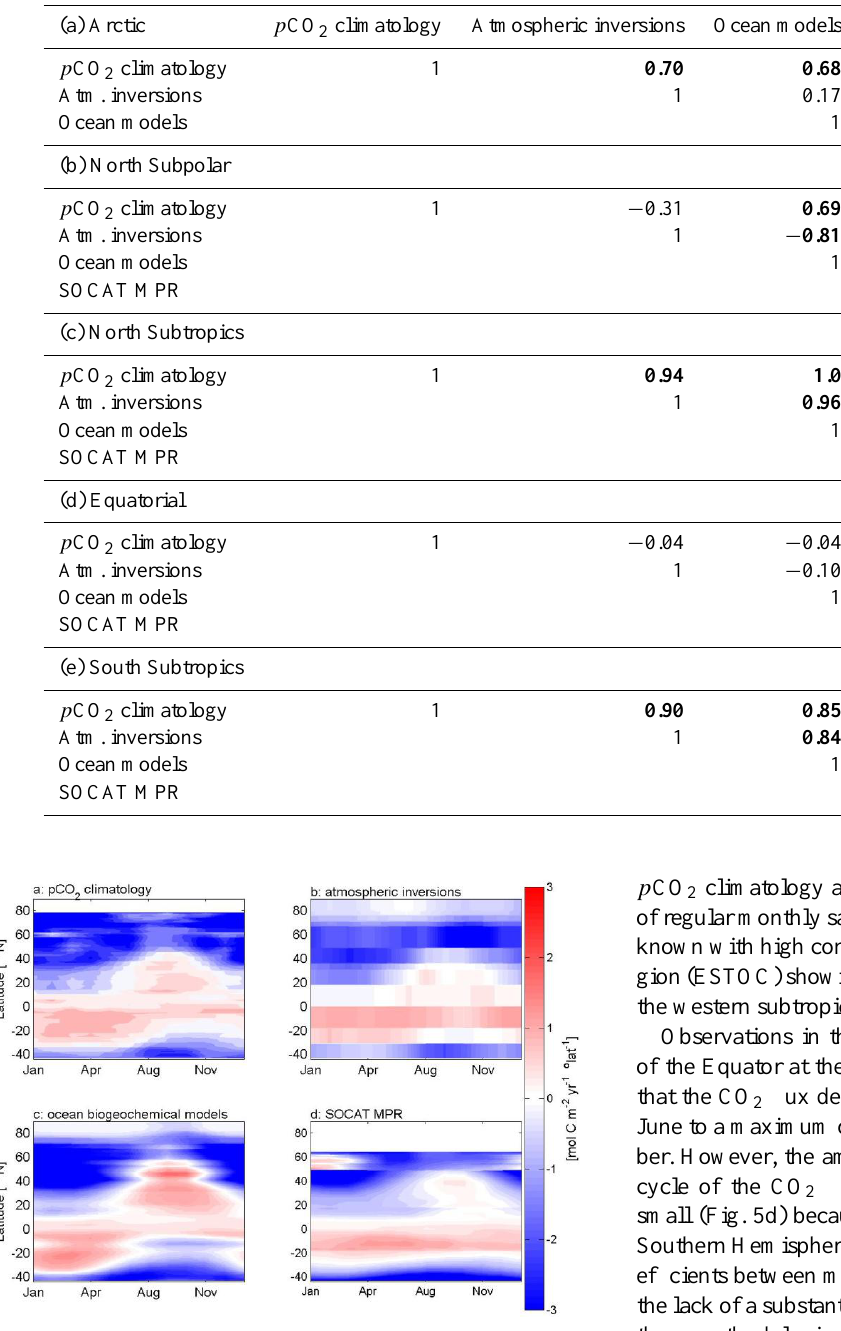
Fig. 4. Zonally averaged long-term mean seasonal cycle of Atlantic sea–air CO 2 flux density [molCm − 2 yr − 1 per degree of latitude], based on the Tier 1 methodologies: (a) p CO 2 climatology, (b) me- dian of atmospheric inversions, and (c) median of ocean biogeo- chemical models; additionally we show (d) the observations based SOCAT MPR. The p CO 2 database is not shown because it is not a gridded